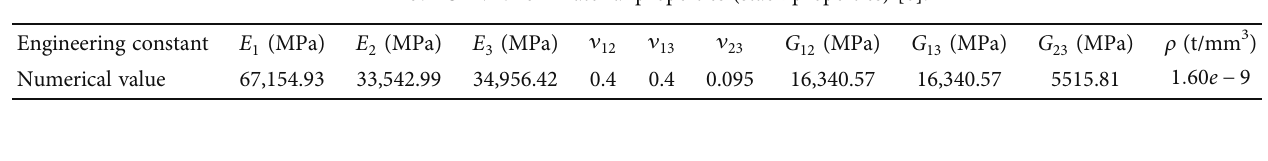
Table 3: AS4-VRM34 material properties (stack properties) [6].